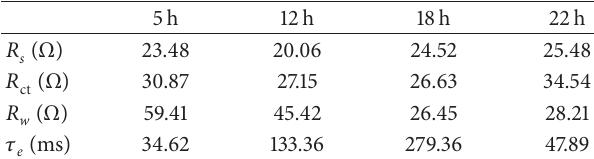
Table 2: Parameters obtained by fitting the impedance spectra of DSSCs using the equivalent circuit in Figure